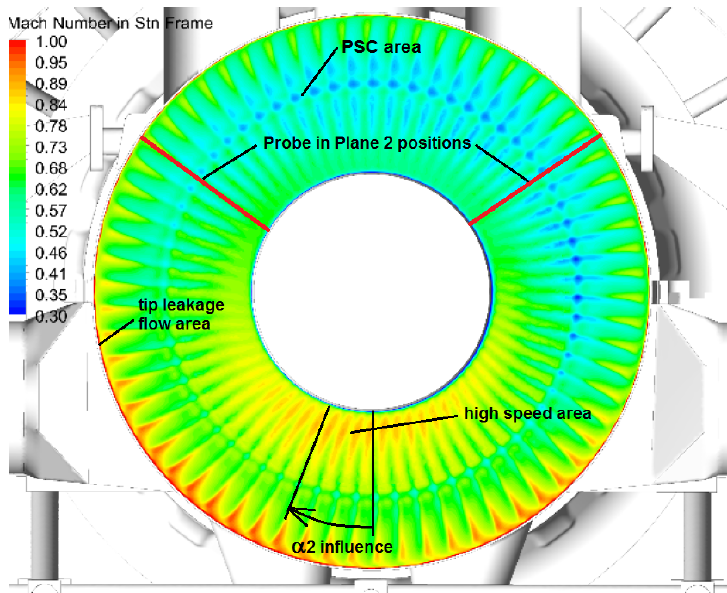
Figure 6. Absolute Mach number in Plane 2.